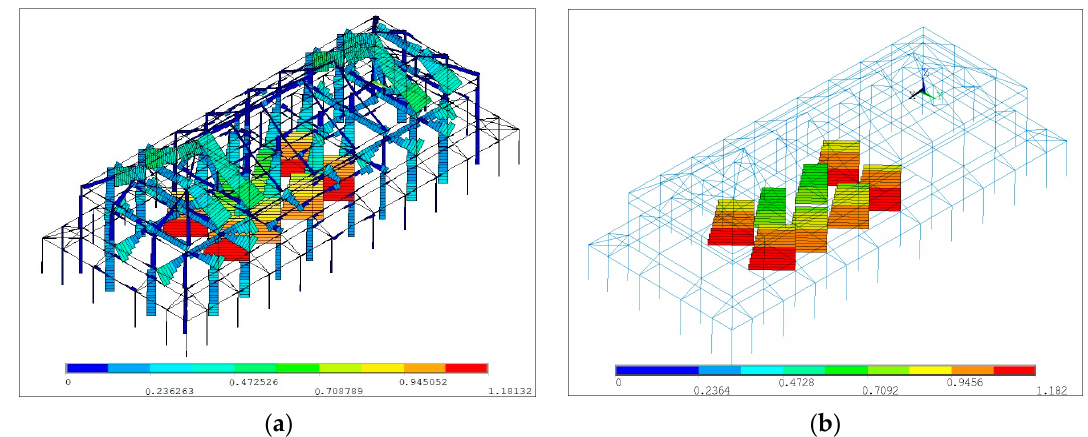
Figure 10. ( a ) The results of component importance analysis for the Songfengge Building; ( b ) the critical components of the Songfengge Building.